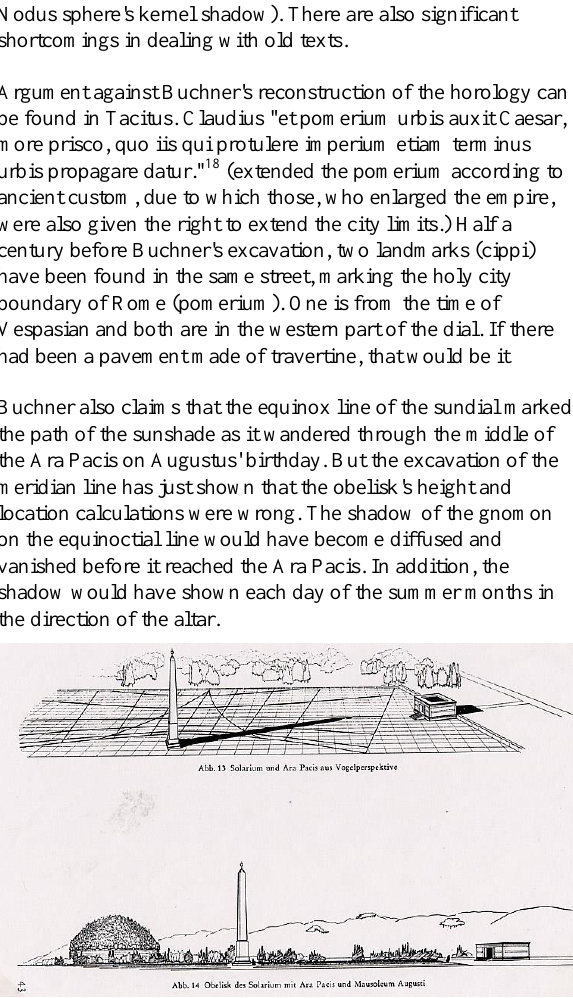
Figure 15: Buchner, Obelisk of the Solarium with Ara Pacis and Mausoleum